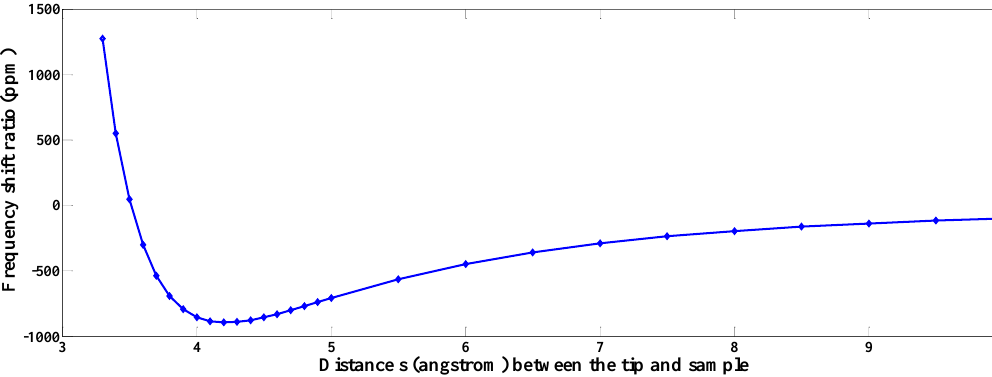
Figure 11. Frequency shift ratio versus the tip-sample distance, including the short-range repulsive regime.